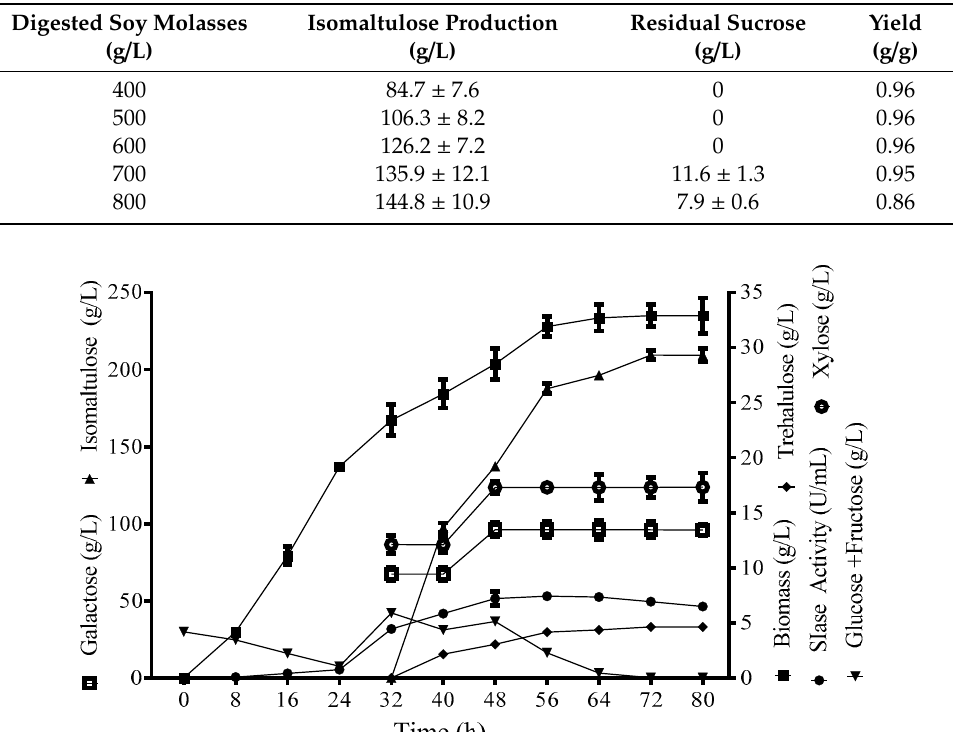
Figure 2. Time course of isomaltulose production, biomass, sucrose isomerase (SIase) activity, and sugar concentrations in the 10-L bioreactor during fermentation by Y. lipolytica S47. Data are given as means ± standard deviation, n = 3. Table 1. Isomaltulose production from soy molasses of different concentrations.